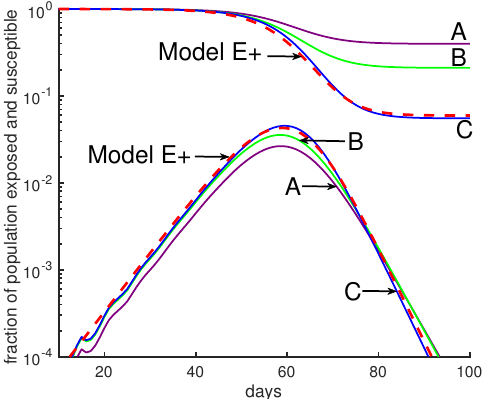
Figure 5. Comparing Model E+’s outbreaks with Model J’s. All simulations in this figure and the next were chosen so that the initial growth rate was a factor of 3 per week. See Table 1 for parameter choices. The initial conditions were chosen so that the 4 curves would be close together initially. Changes in initial data will shift a curve to the left or right. Model E+: The red dashed curve is for Model E+ with a constant contact rate β = 3. Model J: The curves A , B , C , are from Model